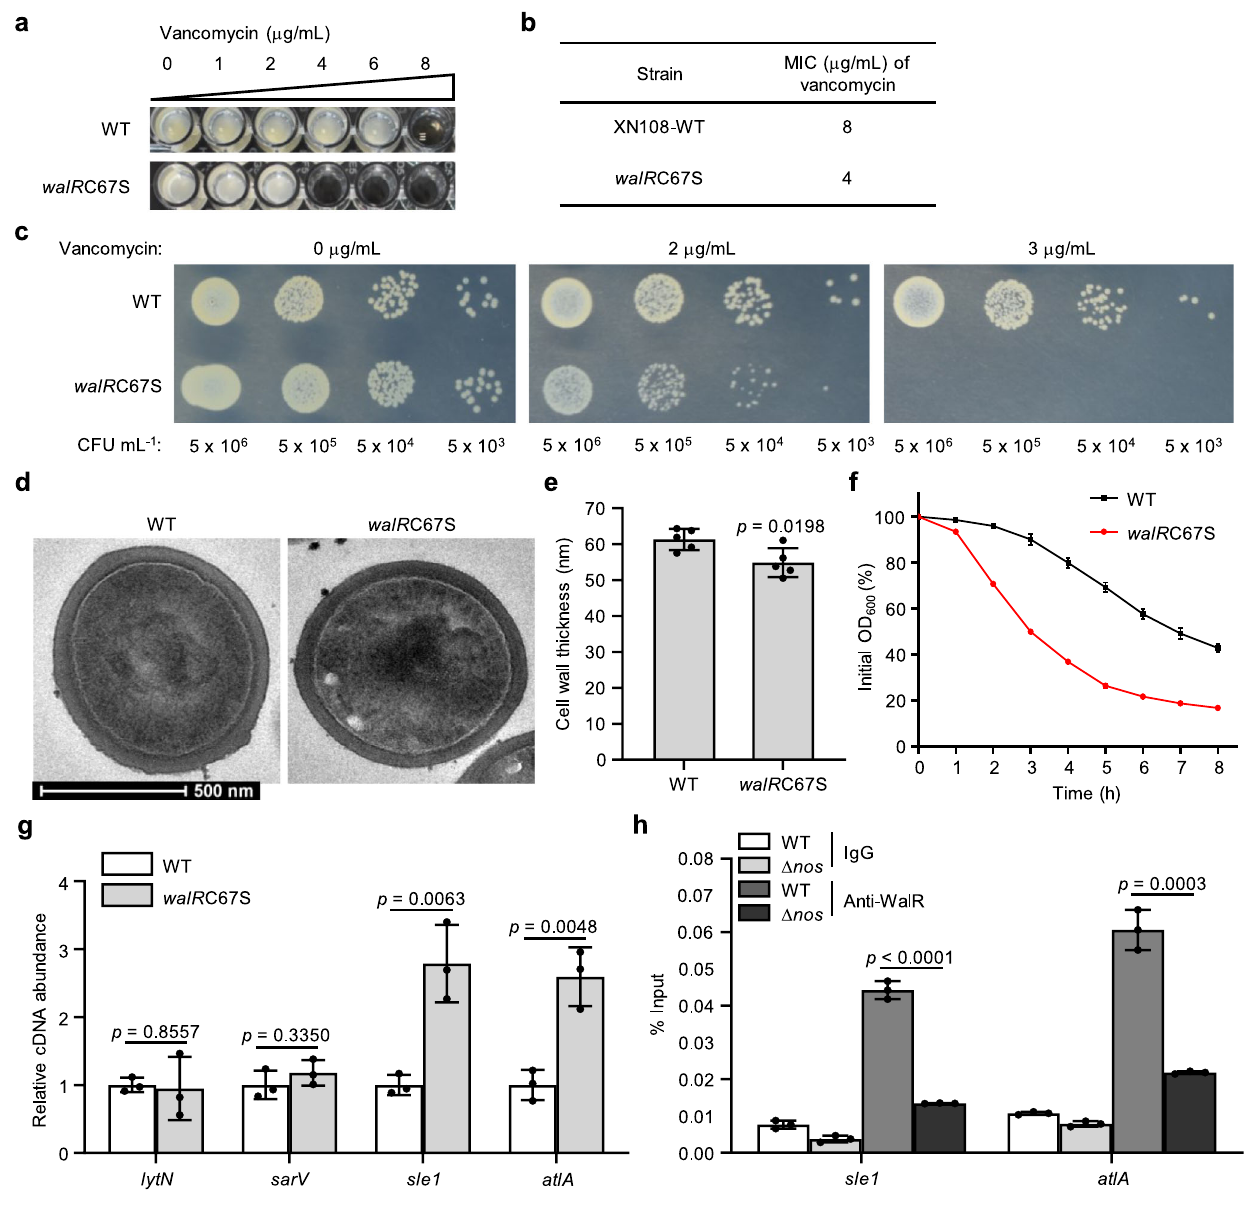
Fig. 6 | WalR adopts S-nitrosylation to confer vancomycin resistance. a MICs were assessed after the WT and walR C67S mutant strains were grown under van- comycin conditions in a 96-well plate with shaking at 200rpm for 48h at 37 °C. Data are representative of n =3 biological replicates. b The difference in MICs observed in a is displayed. c The growth of both strains on normal condition or medium containing different concentrations of vancomycin as indicated on agar plateswasmeasuredbyaplate-sensitivityassay.CFUcolony-formingunits. d , e Cell wall thickness was measured by transmission electron microscopy (TEM). Repre- sentative TEM images of the WT and walR C67S strains cultured with shaking at 220rpmfor16hat37°Caredisplayed( d ).Scalebar=500nm.Cellwallthicknessof n =5 individual cells from each strain were measured three times randomly and